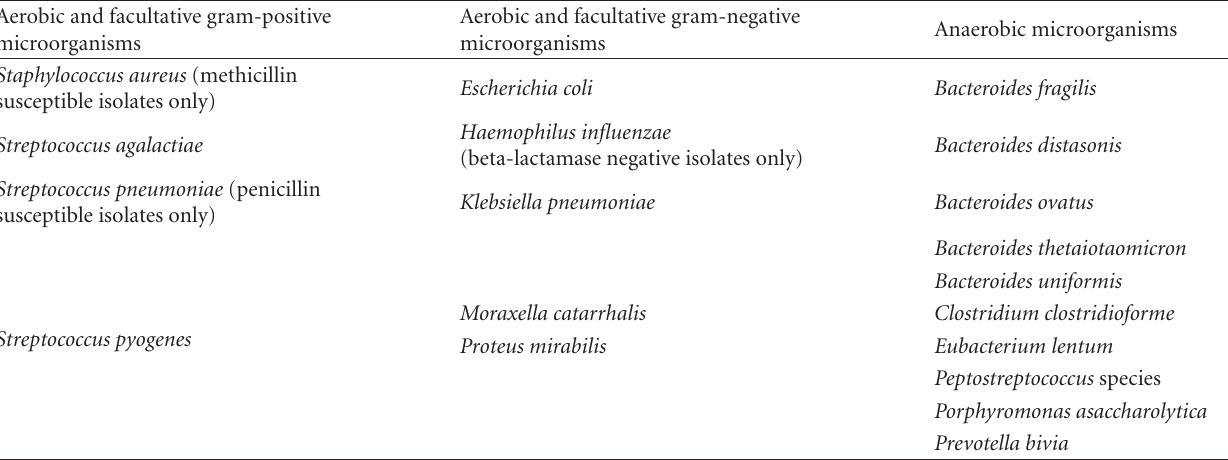
Table 1: Microorganisms that ertapenem has in vitro and clinical activity